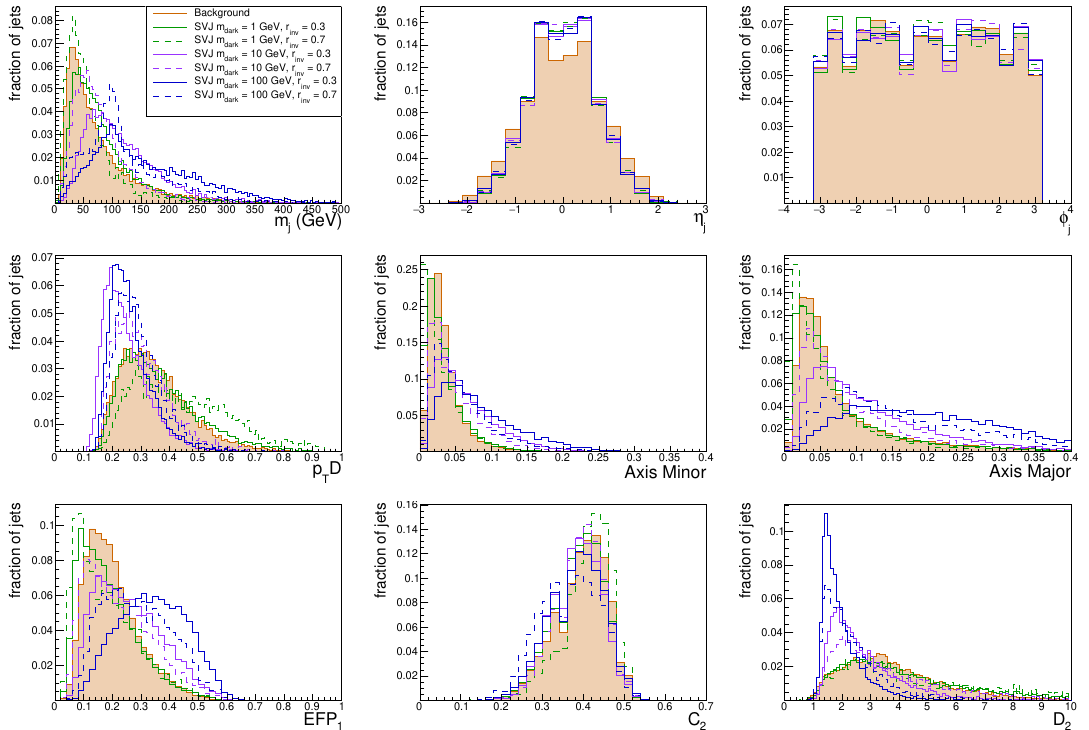
Figure 9. Distributions of input variables for QCD background and signal models with m and varying m dark and r inv